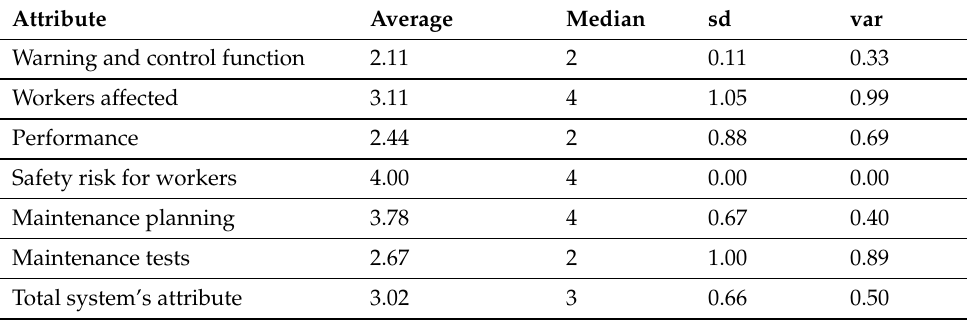
Table 6. Questionnaire results.